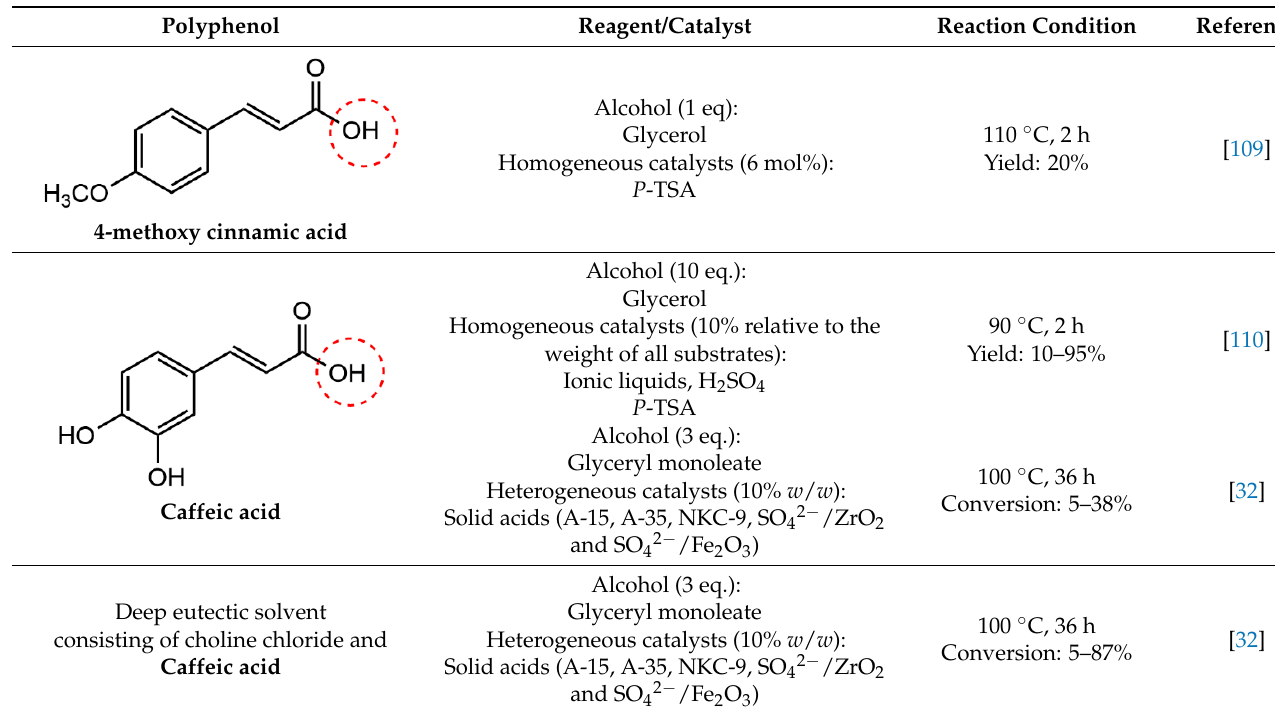
Table 3. Acid-catalyzed synthesis of hydrophilic PEs *.